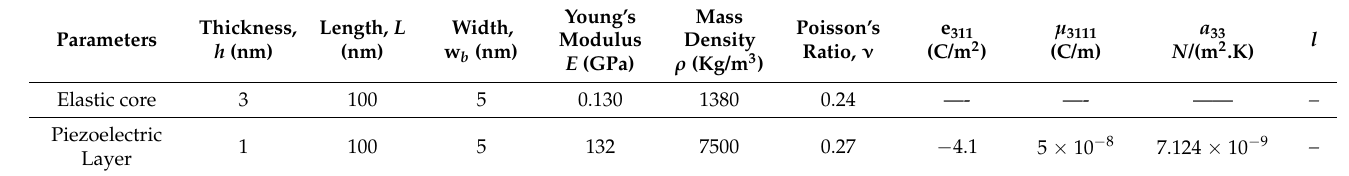
Table 2. Geometrical and material characteristics of the piezoelectric composite